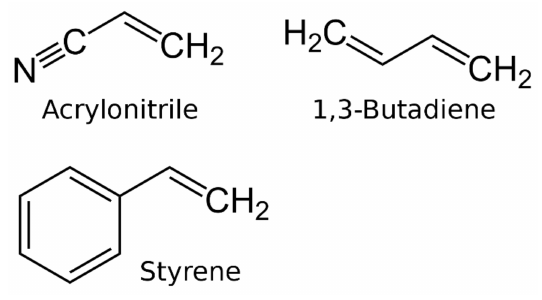
Figure 1. The chemical formula of ABS [43]. Table 1. The physical and mechanical properties of ABS PA-747H and oil palm fiber